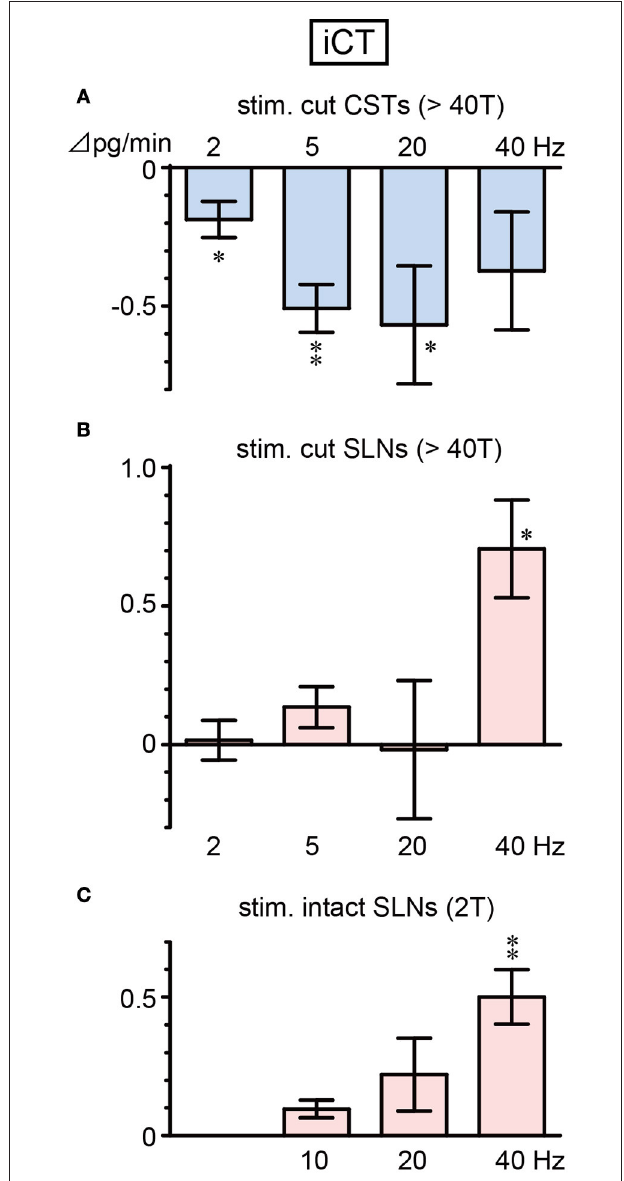
FIGURE 2 | Changes in iCT secretion rate during electrical stimulation of cut CST (A) , cut SLN (B) , and intact SLN (C) at various stimulus frequencies. X-axis: frequency of stimulation. Y-axis: changes in iCT secretion rate from prestimulus control values. Columns and vertical bars show the mean ± standard error. Significant differences were determined by comparison with the prestimulus control values (* p < 0.05, ** p <